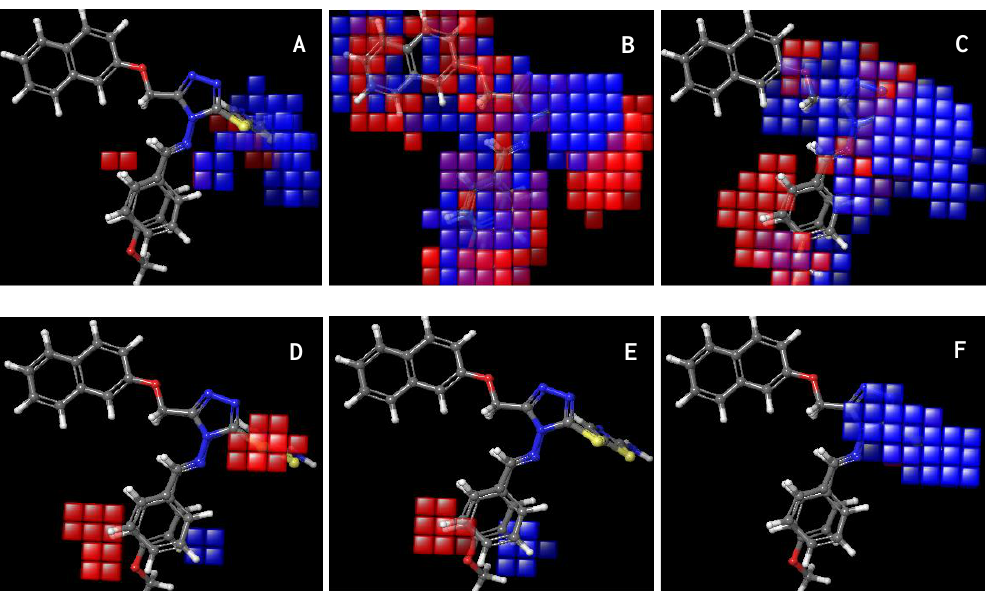
Figure 5. QSAR model visualized in the context of hydrogen bond donor (favorable and unfavorable) in ( A ), hydrophobic interactions in ( B ), electron-withdrawing groups in ( C ), positive ionic in ( D ), negative ionic in ( E ), and other feature in ( F ) for the highest and lowest active compounds 12d and 9a , respectively.